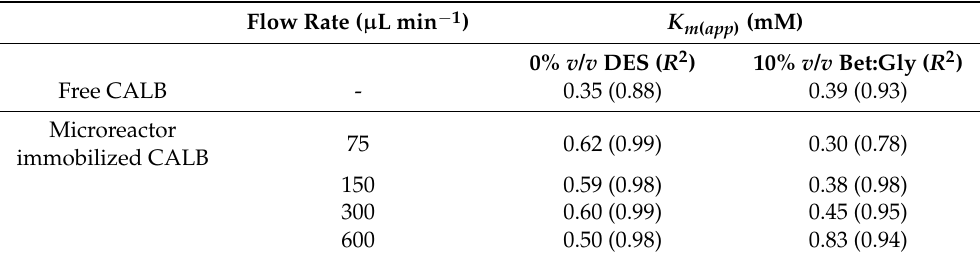
Table 3. Apparent Michaelis constant ( K m ( app ) ) calculated from the Lilly − Hornby model for the mi- croreactor system and Michaelis constant for the free enzyme calculated from the Michaelis − Menten model, under the same reaction conditions.